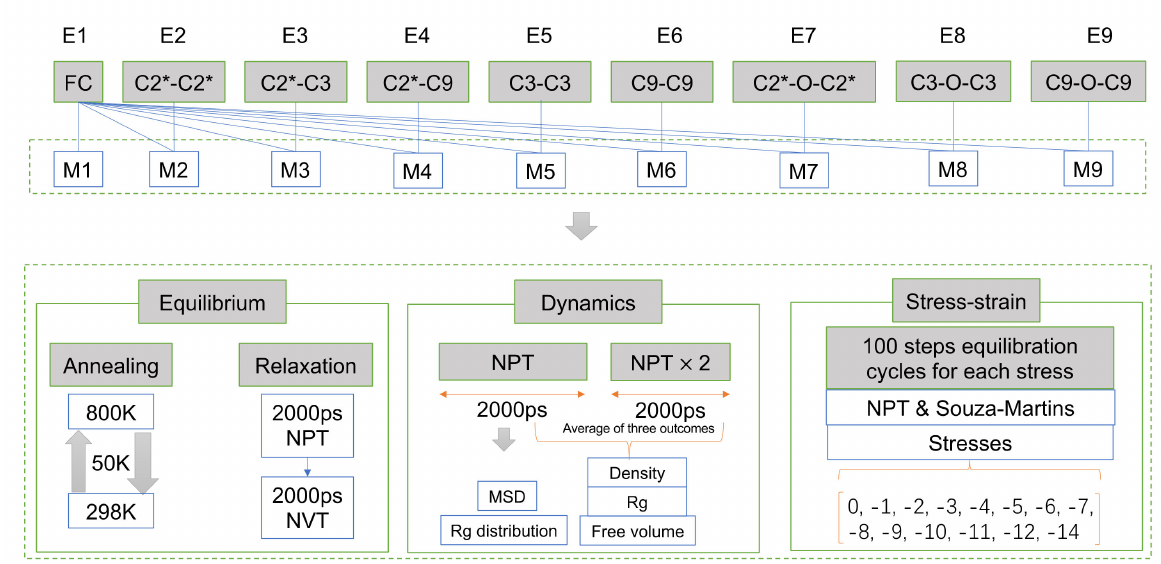
Figure 5. The workflow of molecular dynamics simulations in this